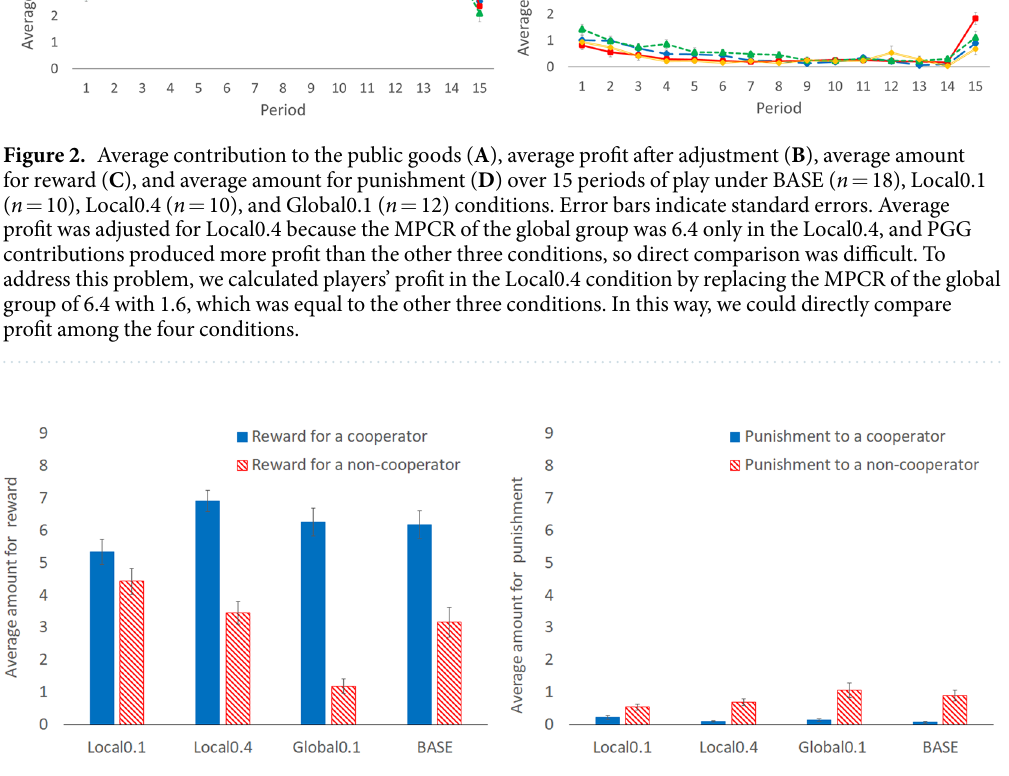
Figure 3. Average amount of reward and punishment to cooperator (equal-to- or above-average contributor)/ non-cooperator (below-average contributor) over periods 1–14. Error bars indicate standard